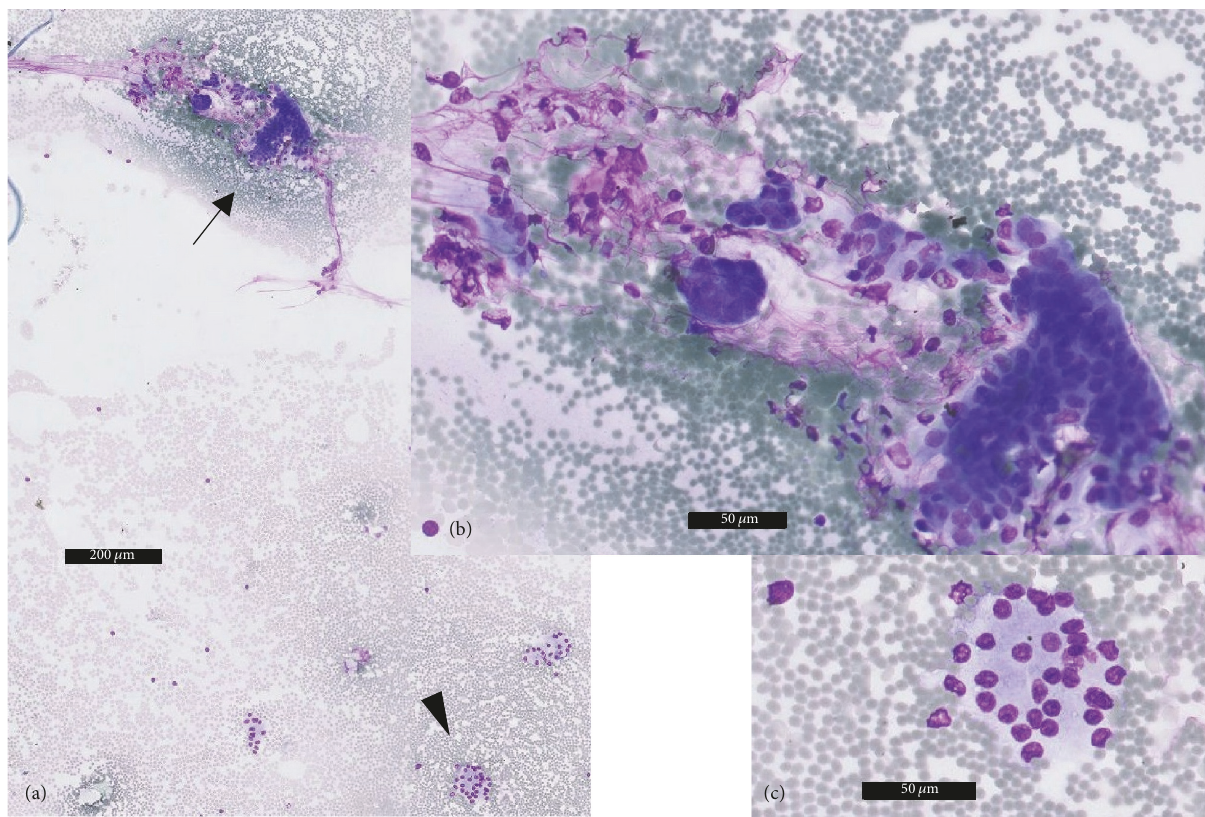
Figure 5: Fine-needle aspirate of the mesenteric soft tissue mass, MGG staining. (a) Overview, magnification 50x. Both groups of ductal cells (black arrow) and acinar cells (black arrowhead) are depicted in this image. (b) Magnification 200x, details of the cylindrical ductal cells. (c) Magnification 200x, details of the acinar pancreatic cells.